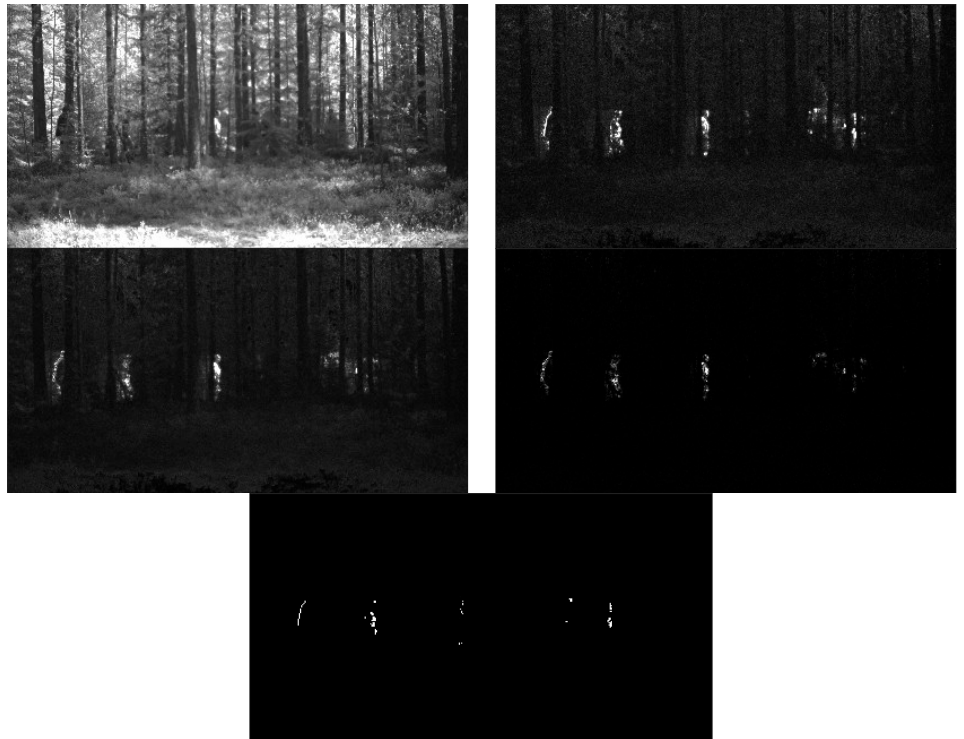
Figure 7. Illustration of the algorithm. Top left : original frame (one spectral band). Top right : resid- ual ( L 1 -norm) image. Middle left : moving median. Middle right : moving standard deviation. Bottom : post-processed foreground